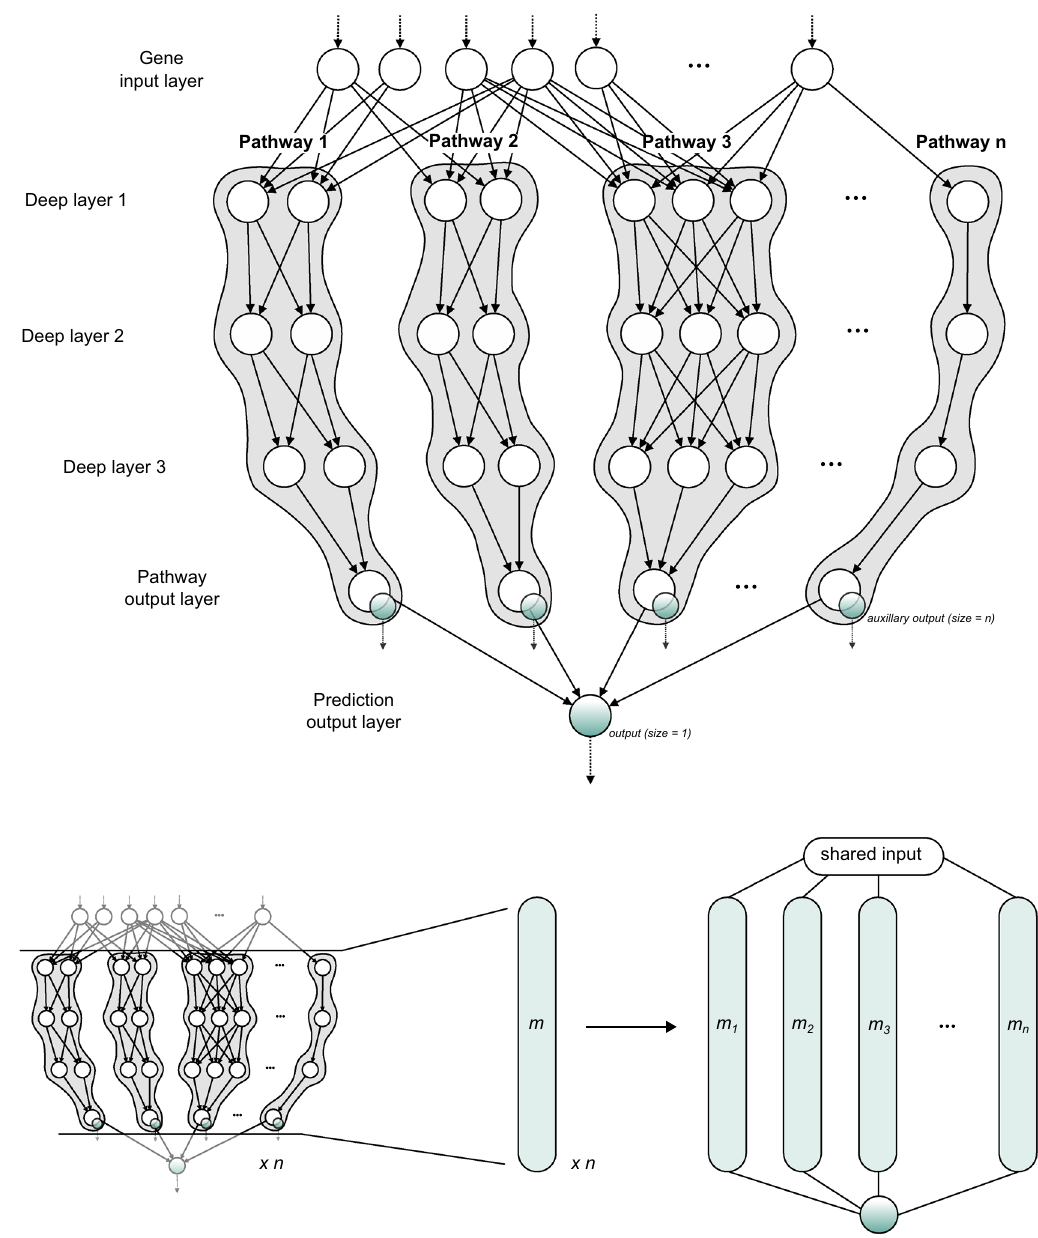
Fig. 1 Model architecture and setup. a Schematic of the arti fi cial neural network architecture. Gene expression data is fed to the input layer, which is connected to the following hidden layer through gene-speci fi c edges that are constructed based on pathway af fi liation. In the following hidden layers, information is processed by the network in a pathway-centric manner culminating into a fi nal linear pathway layer with one neuron per pathway, which also serves as an auxiliary output to monitor pathway aging states. Finally, the information from all pathway neurons is aggregated in the main output neuron, which generates the age prediction. b Ensemble setup. To improve the stability and accuracy of the fi nal model, an ensemble model was constructed from individually trained networks by joining the separate models to the common input and output studies, to evaluate if the predictions accurately replicated the associations through a series of in silico experiments. As discussed effects of the perturbation (Fig. 3a). The knockdown of SIRT1 for above, past research has not identi fi ed a single ‘ master switch ’ example, a widely studied NAD-dependent deacetylase with gene or pathway driving aging, nonetheless, several genes have various conserved pro-longevity functions, has been shown to been identi fi ed over the years, whose deregulation is associated have detrimental effects on the lifespan of several models with changes in lifespan in model organisms or the manifestation organisms 21 – 24 . Indeed, simulation of a decreased SIRT1 regulation of aging phenotypes. To test if the model could recapitulate such associations, we performed virtual gene knockdowns of known by a log2 fold-change of − 2 using our model predicted a aging target genes with a history of experimental data available signi fi cant age increase for all subjects in our test set, in from model organisms and human genome-wide association concordance with expectations and data from the literature. In